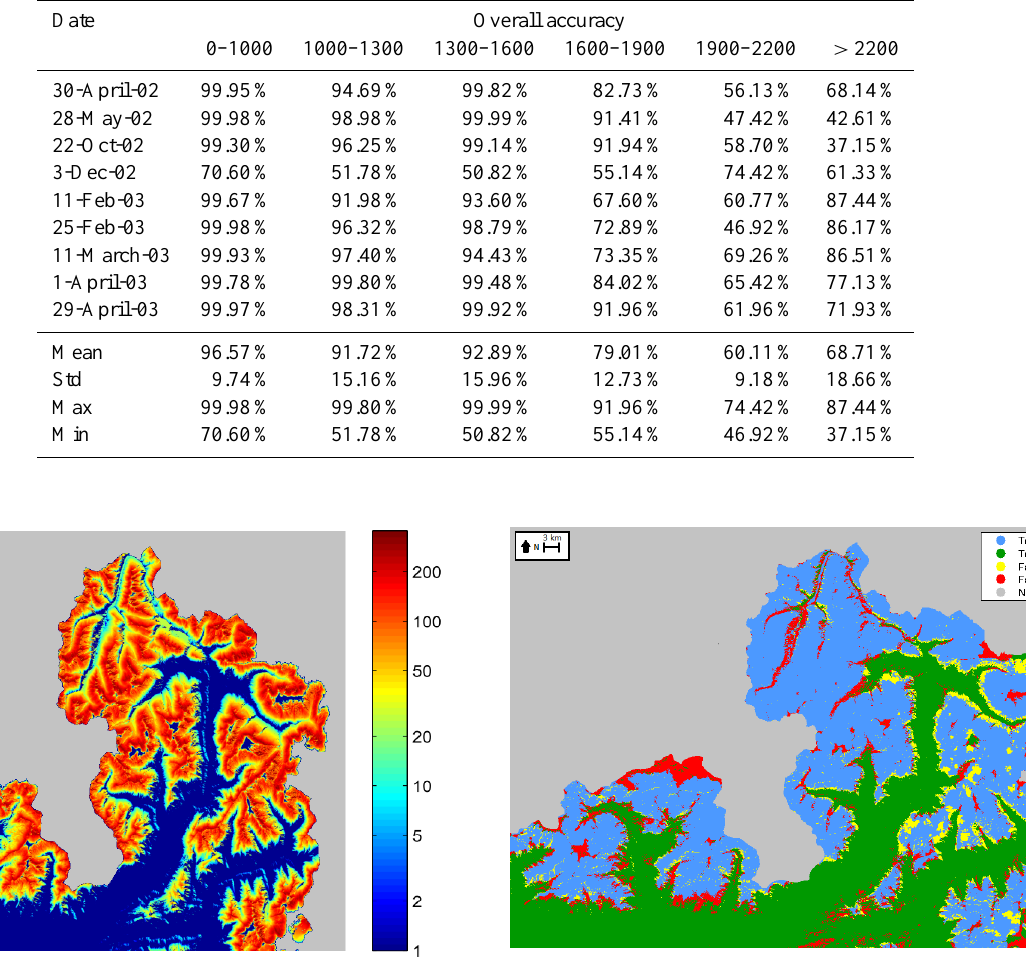
Fig. 7. Overlapping of maps produced by the RBFN Network and NDSI. Considering the RBFN map as the first result and the NDSI map as the second, colors have the following meaning: Blue=PS-PS; Green=AS-AS; Yellow=PS-AS; Red=AS-PS, with PS=Presence of Snow and AS=Absence of